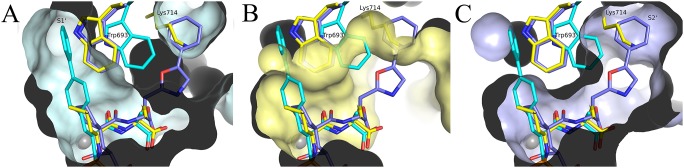
Plasticity in S1’ and S2’ substrate binding pockets.Superposition of 1r1h (cyan), NEPv (yellow) and 2yb9 (violet), illustrating flexibility of size and shape of S1’ and S2’ subsites. Protein surfaces of each complex are shown: A) 1r1h B) NEPv C) 2yb9. The inner parts of the S1’ and S2’ sub pockets will probably not be accessible in NEPv.